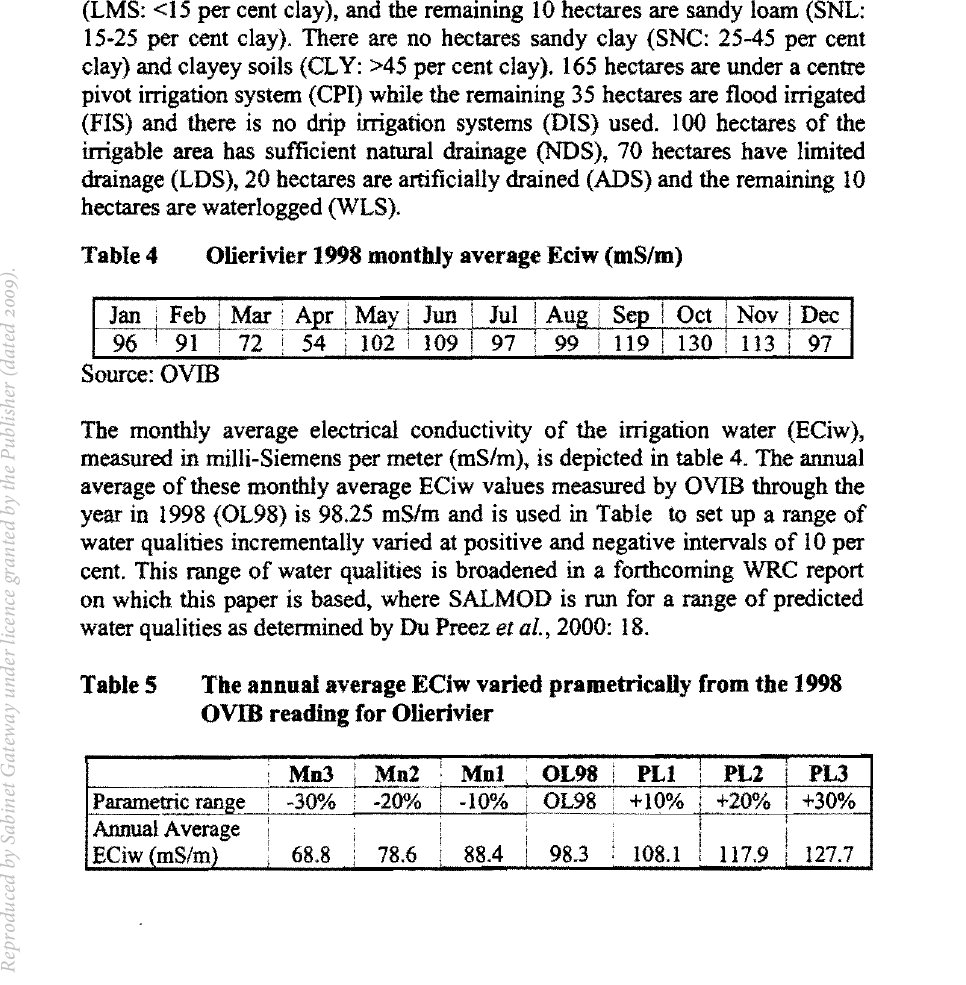
Olierivier 1998 monthly average Eciw